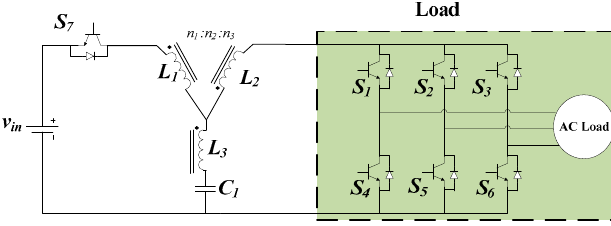
Figure 6. Bidirectional Y-source inverter topology.